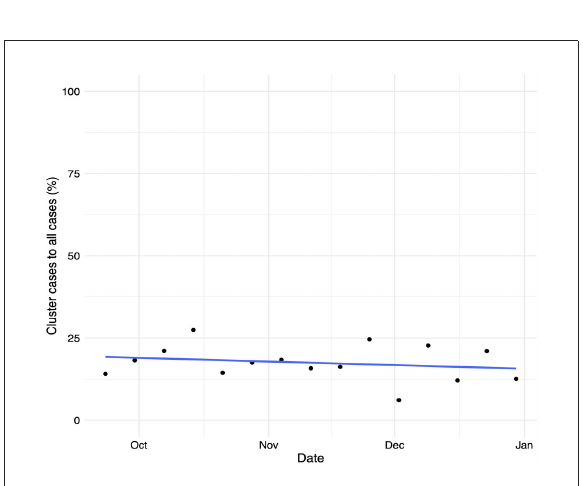
FIGURE5 Distribution of the type of origin of the analyzed COVID-19 outbreaks throughout the period of study (16 weeks from September 15th till December 29th).